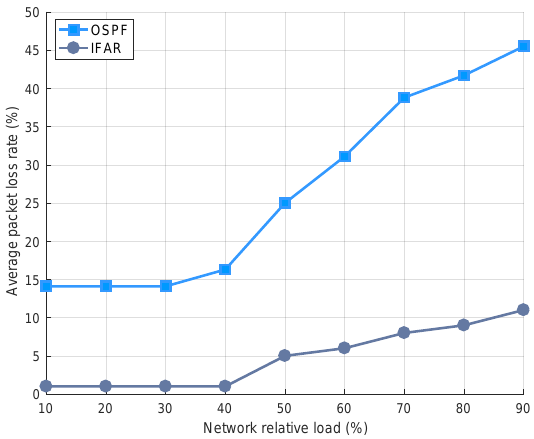
Figure 7. The average packet loss rate of users under different network